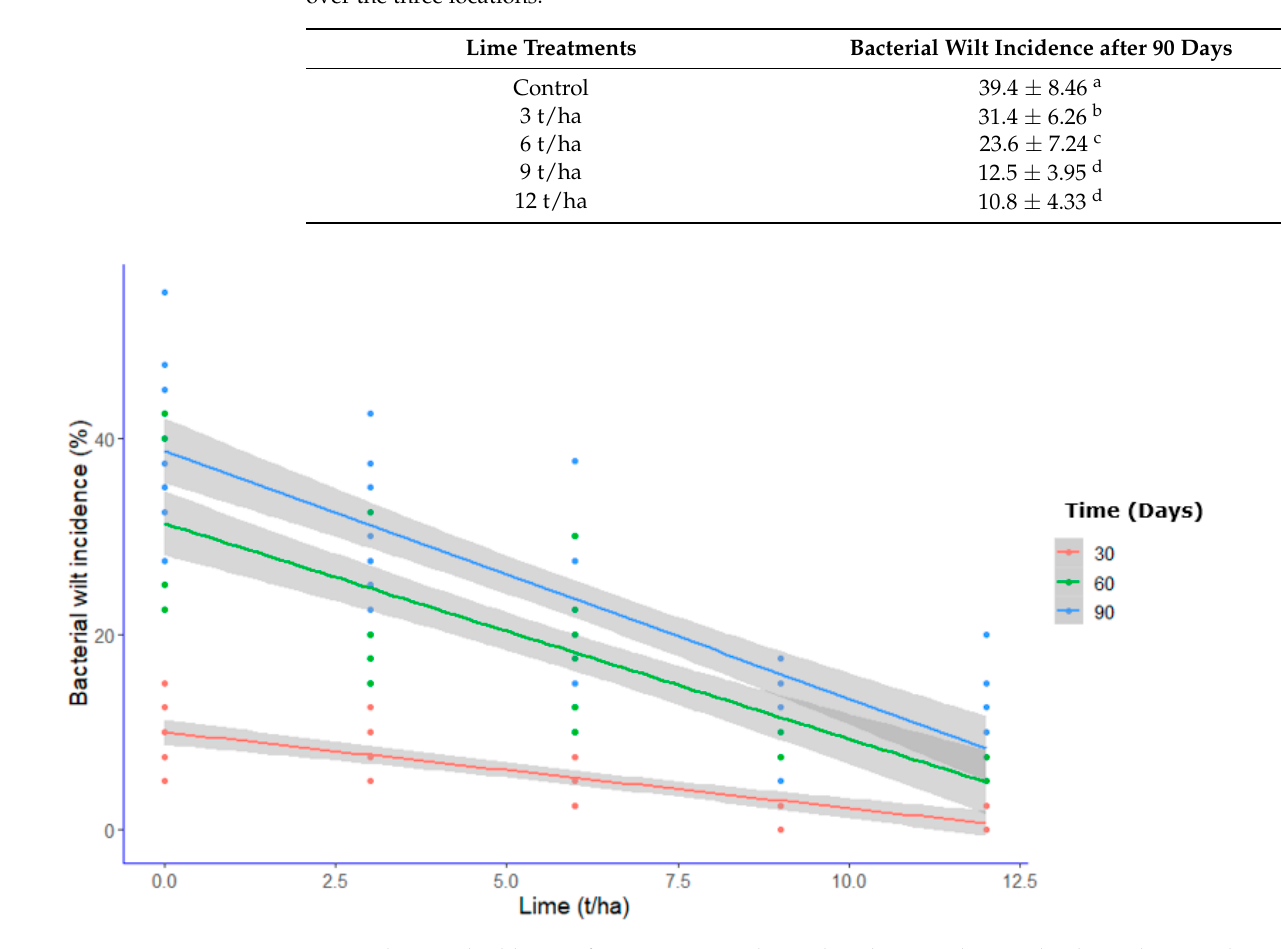
Figure 5. Linear regression curves showing highly significant negative relationships between bacterial wilt incidence and lime application for three dates of disease observation after inoculation (R = − 0.80, p = 2.8 × 10 –11 for time after 30 days; R = − 0.84, p = 8.8 × 10 –13 for time after 60 days; R = − 0.87, p = 1.74 × 10 –14 for time after 90 days). Table 3. Effects of different lime application rates on bacterial wilt incidence (values in the same column followed by the same letter do not differ significantly ( p < 0.05)). The values are averaged over the three locations.